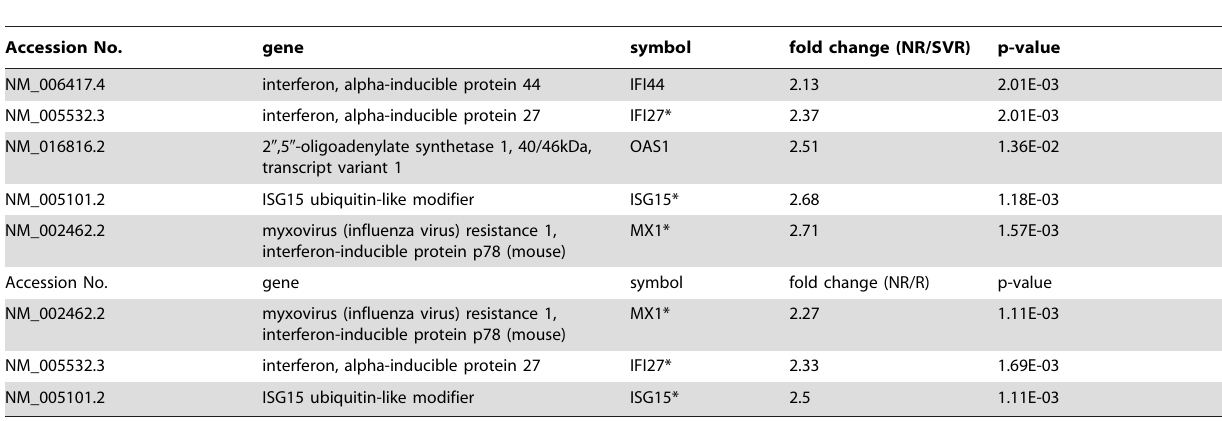
Table 2. Extracted genes related to the clinical outcome with a fold change greater than or equal to 1.5 between two groups (NR/ SVR, NR/R) (p , 0.05).